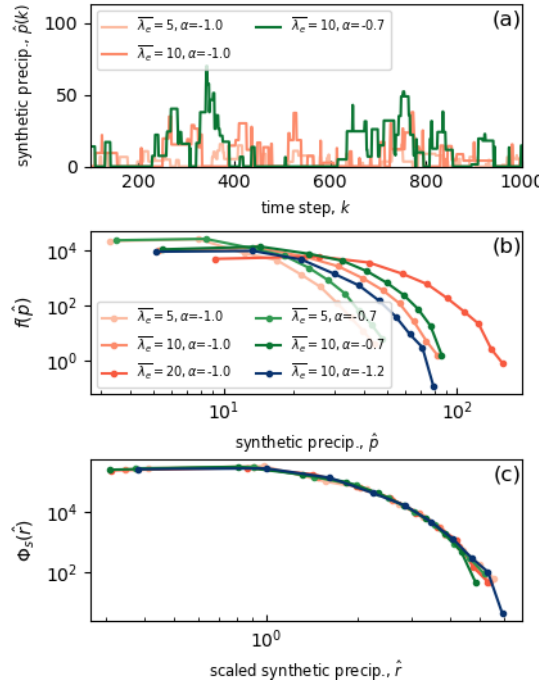
Figure 12. The parameter dependencies of the synthetic rainfall rates generated by the stochastic rainfall generator for three values of the duration-exponent parameter, α (colours), and three values of the event-mean intensity, λ e (shading). (a) Subsections of the time series of synthetic rainfall for three of the parameter combina- tions. (b) The frequency distributions of synthetic rainfall. (c) The re-normalised distributions of the scaled synthetic